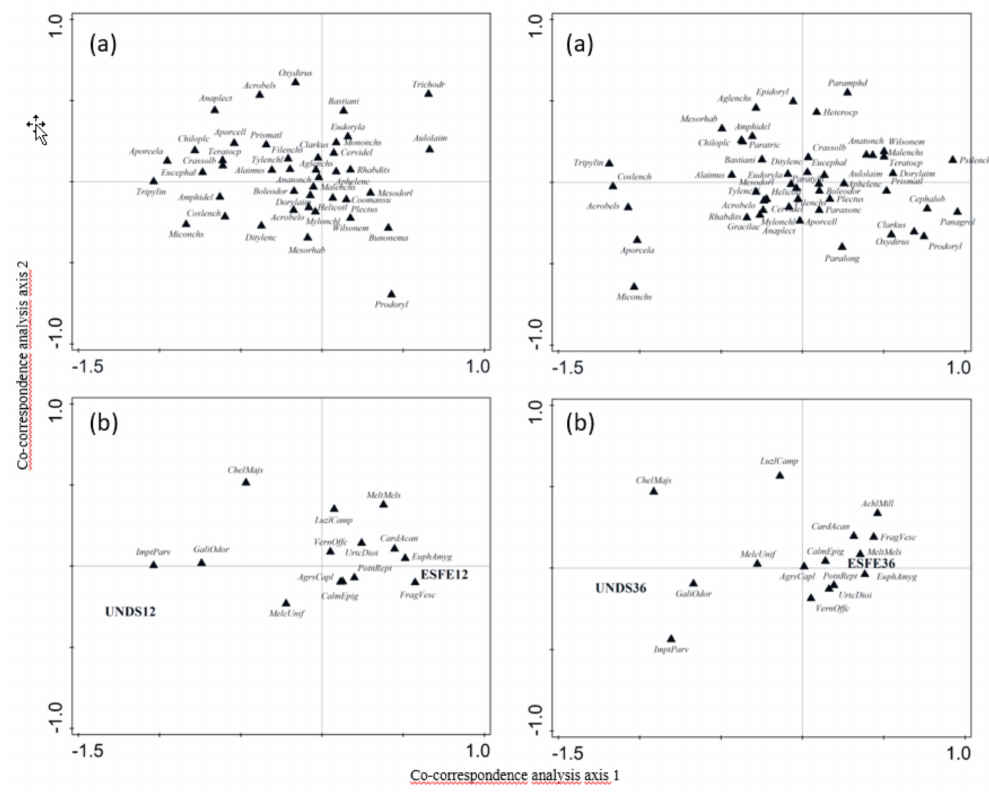
Figure 4. Biplot based on symmetric Co-Correspondence analysis illustrating the nematode community structure ( a ) and their mutual links with plant species ( b ) common in disturbed (ESFE12, ESFE36) and undisturbed plots (UNDS12, UNDS36), 12 and 36 months after event; 44.6% and 39% of the total variance of each data set. Correlation coe ffi cients between nematode-plants derived site scores of the first three axes of symmetric correspondence canonical analysis (axis 1:0.962, λ 1 = 0.0315, p = 0.002, axis 2:0.920) and (axis 1: 0.946, λ 1 = 0.020, p = 0.030, axis 2:0.925) respectively. Codes of panel ( a ) are given in Figure 2; codes of panel ( b ) in are given in Table